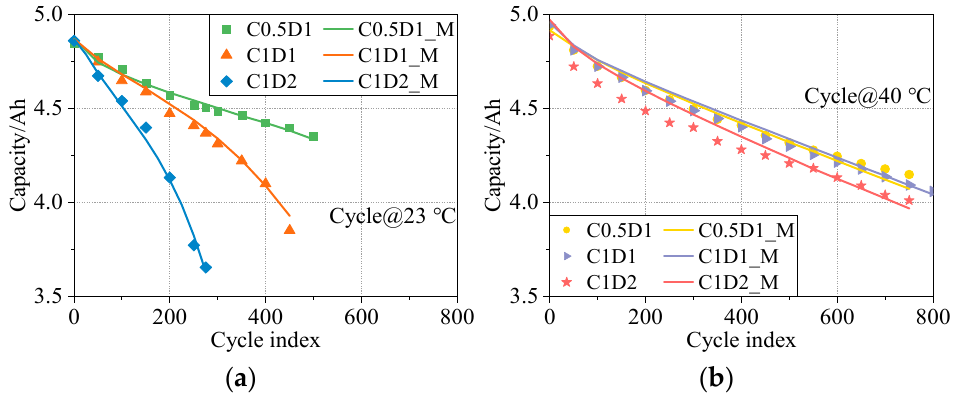
Figure 6. Validation of battery capacity under different conditions of cycle aging at ( a ) 23 °C and ( b ) 40 °C.